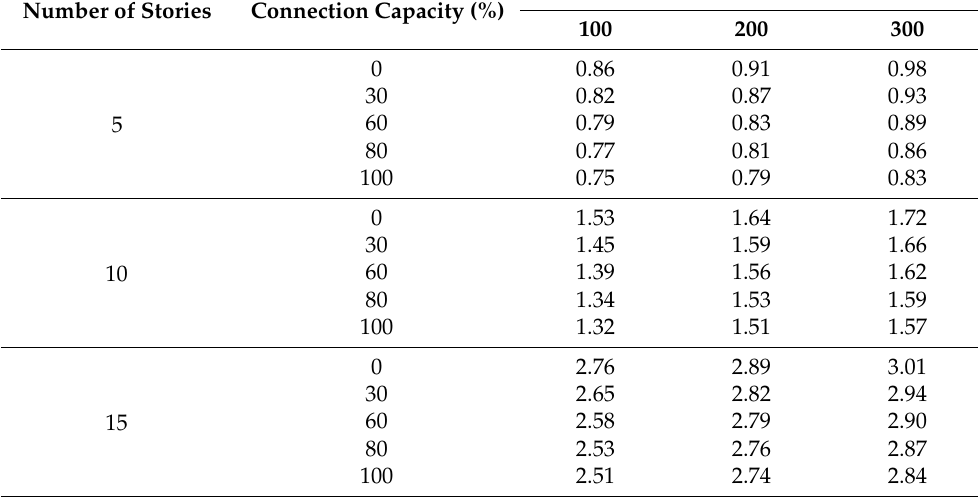
Table 5. Main periods of the frames(s).